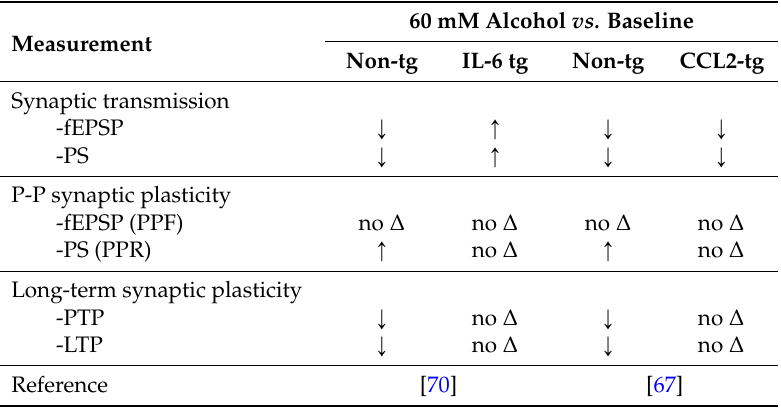
Table 4. Effects of alcohol on synaptic function in